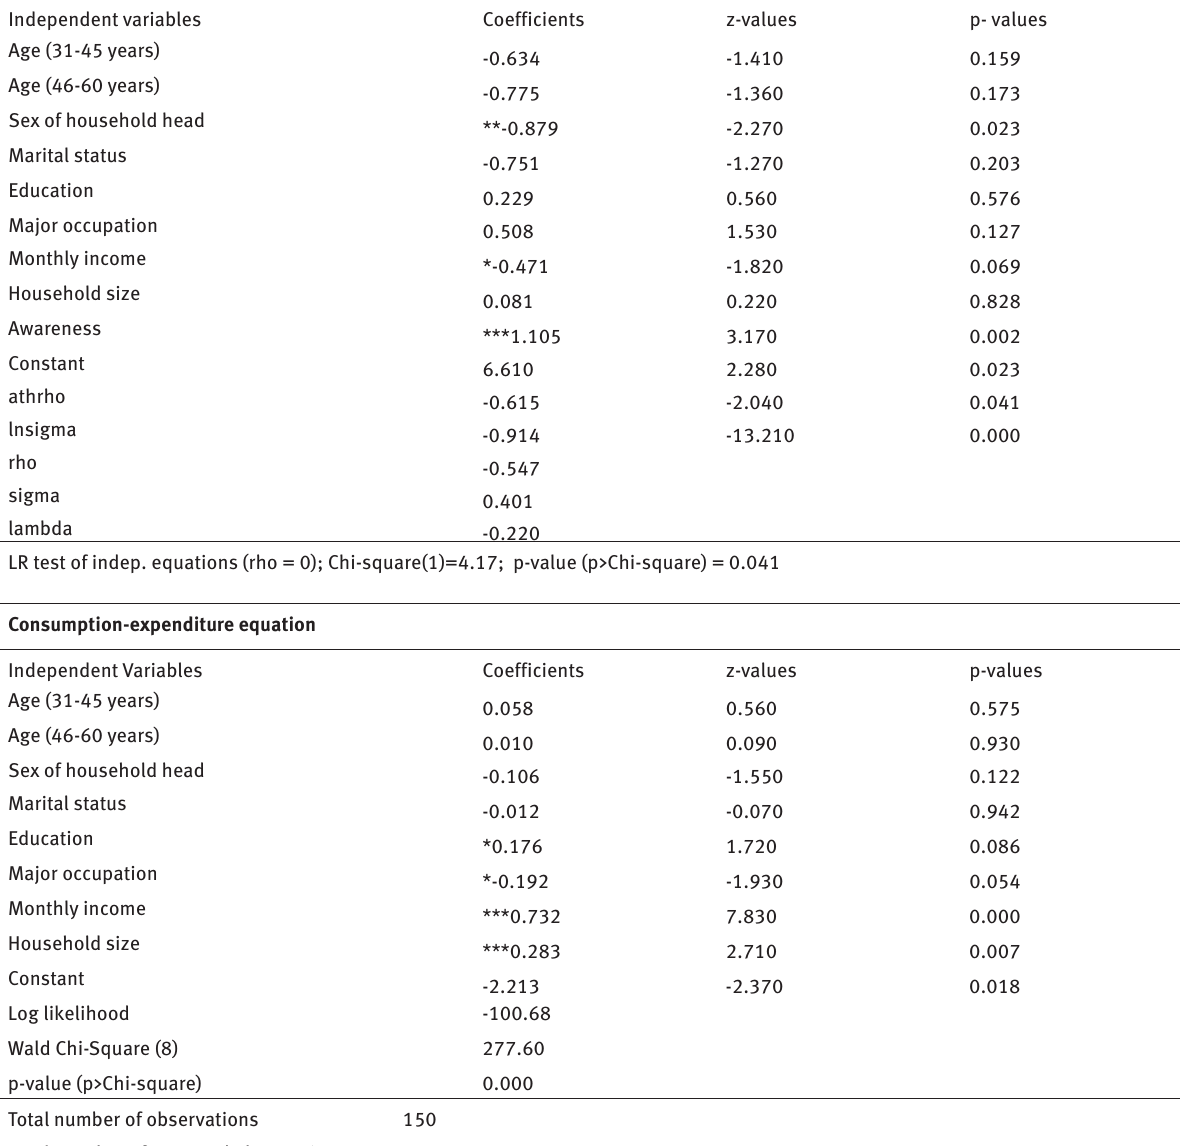
Table 3: Determinants of Decision to consume Garlic and its Consumption-expenditure Decision to consume (selection